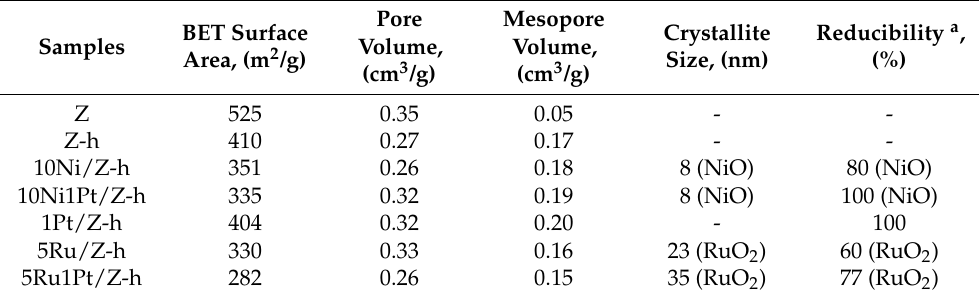
Table 1. Physico-chemical properties of the Z, Z-h and Ni-, Ru- and Pt-modified Z-h zeolites.